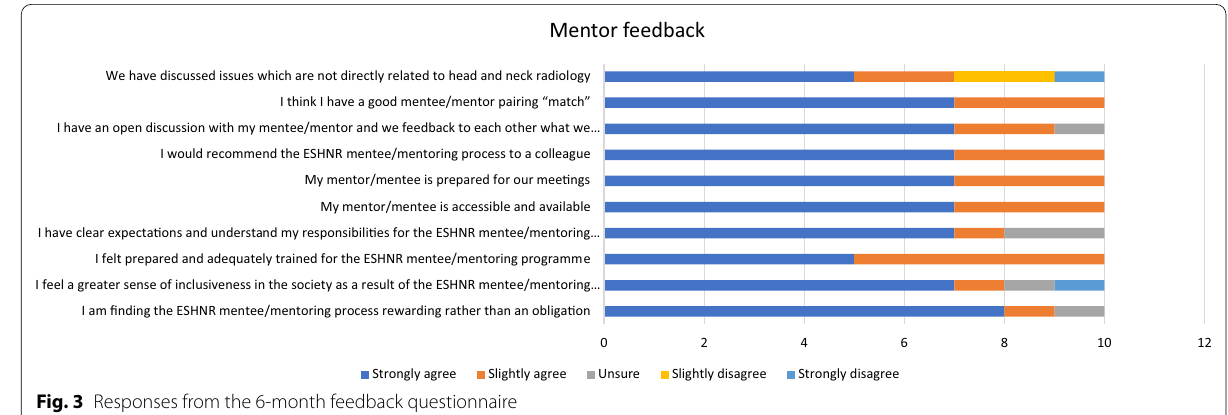
Fig. 3 Responses from the 6-month feedback